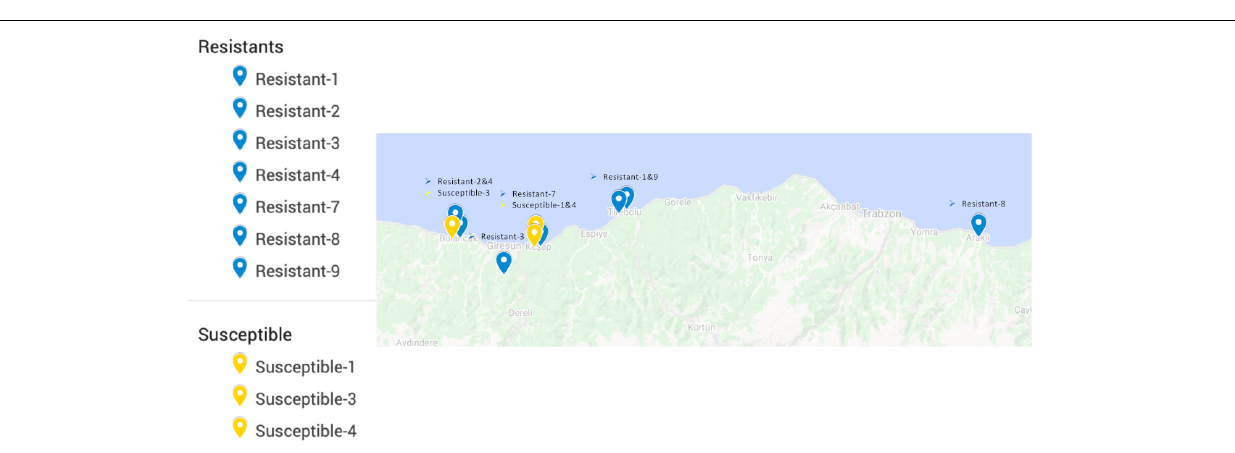
FIGURE 1 | Locations from which samples of nine hazelnut varieties were collected in 2016–2017.